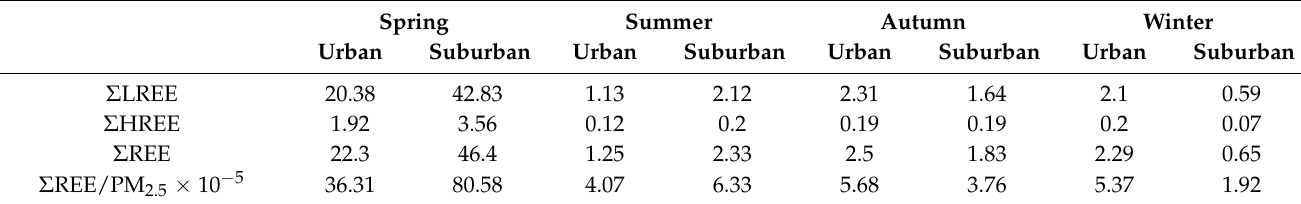
Table 1. Mean concentrations (ng/m 3 ) of Σ LREE, Σ HREE and Σ REE in PM 2.5 and the ratios of Σ REE to PM 2.5 in Xiamen city. Spring Summer Autumn Winter Urban Suburban Urban Suburban Urban Suburban Urban